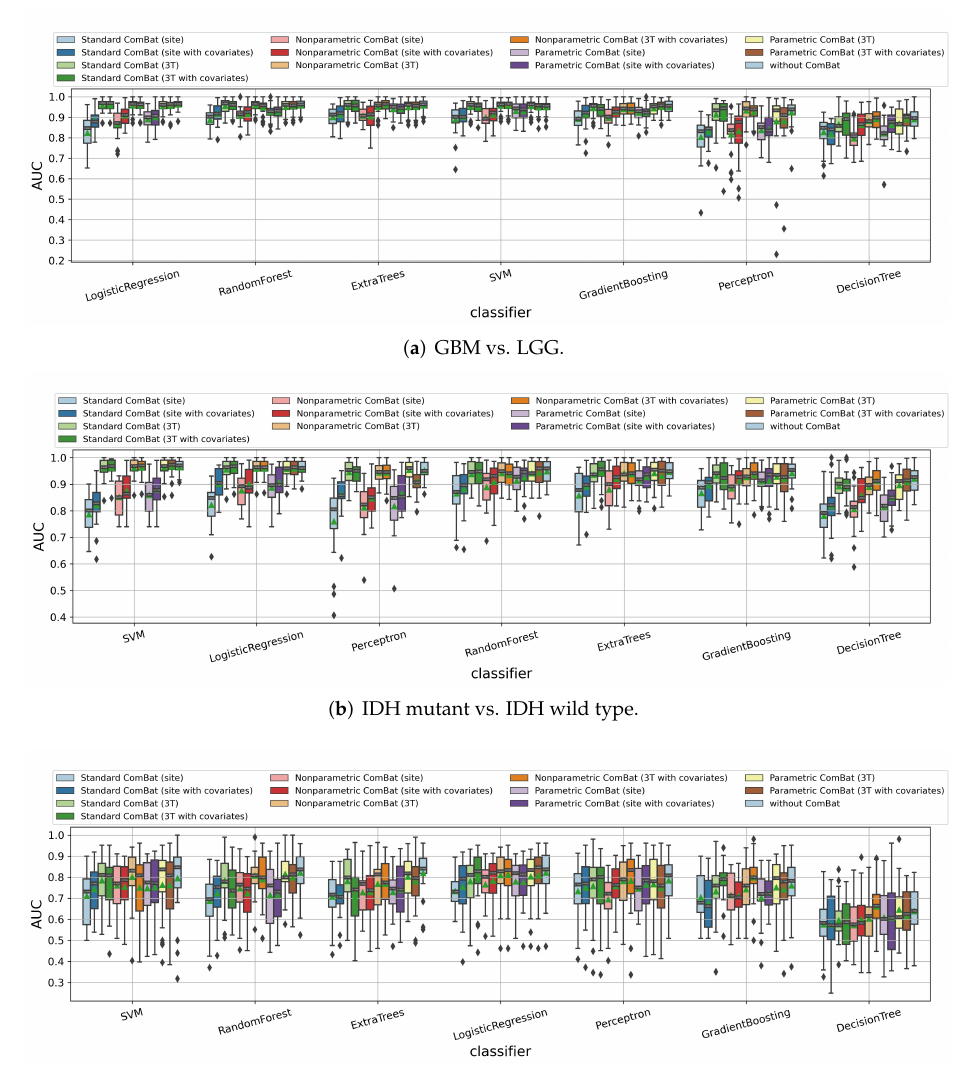
Figure 7. Impact of ComBat harmonization on predicting ( a ) tumor grade, ( b ) IDH mutation status, and ( c ) 1p/19q codeletion status of the gliomas. Here “site” corresponds to using the institution/site label as the scanner setting label during harmonization, while “3T” represents using the magnetic field strength (1.5T or 3T) as a scanner setting label. “With covariates” means keeping the age and sex information during the harmonization